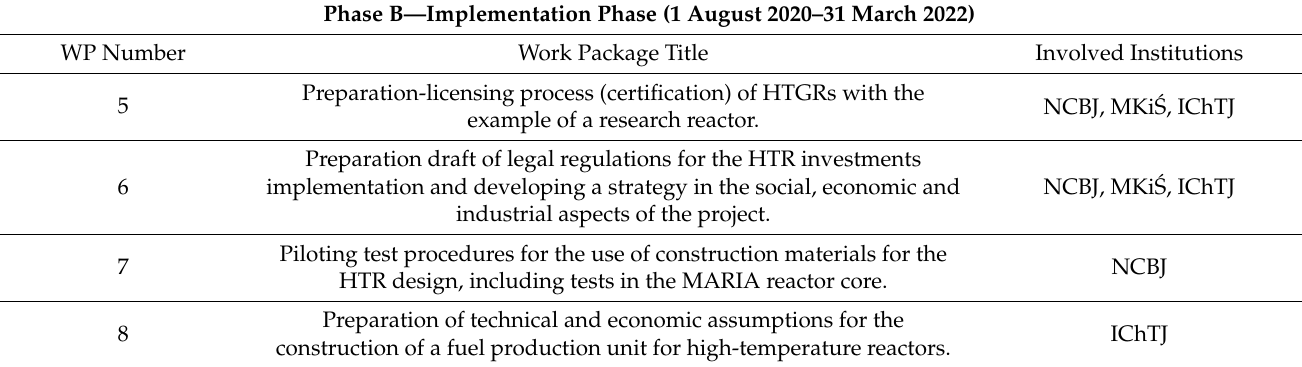
Table 2. GOSPOSTRATEG-HTR project Phase